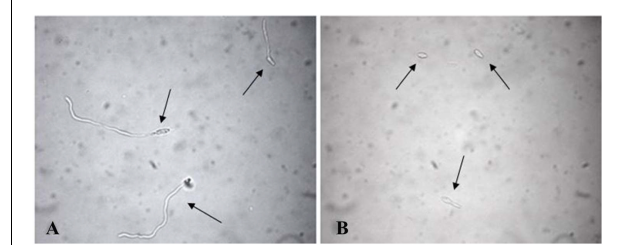
FIGURE 1 | Conidia of Fusarium proliferatum (AACC0215) germinated in distilled water (A) and in presence of Ole (B) after 24 h. The samples were observed under an optical microscope at X400 magnification. The “arrow heads” indicate the germinated (A) and the non-germinated conidia (B)